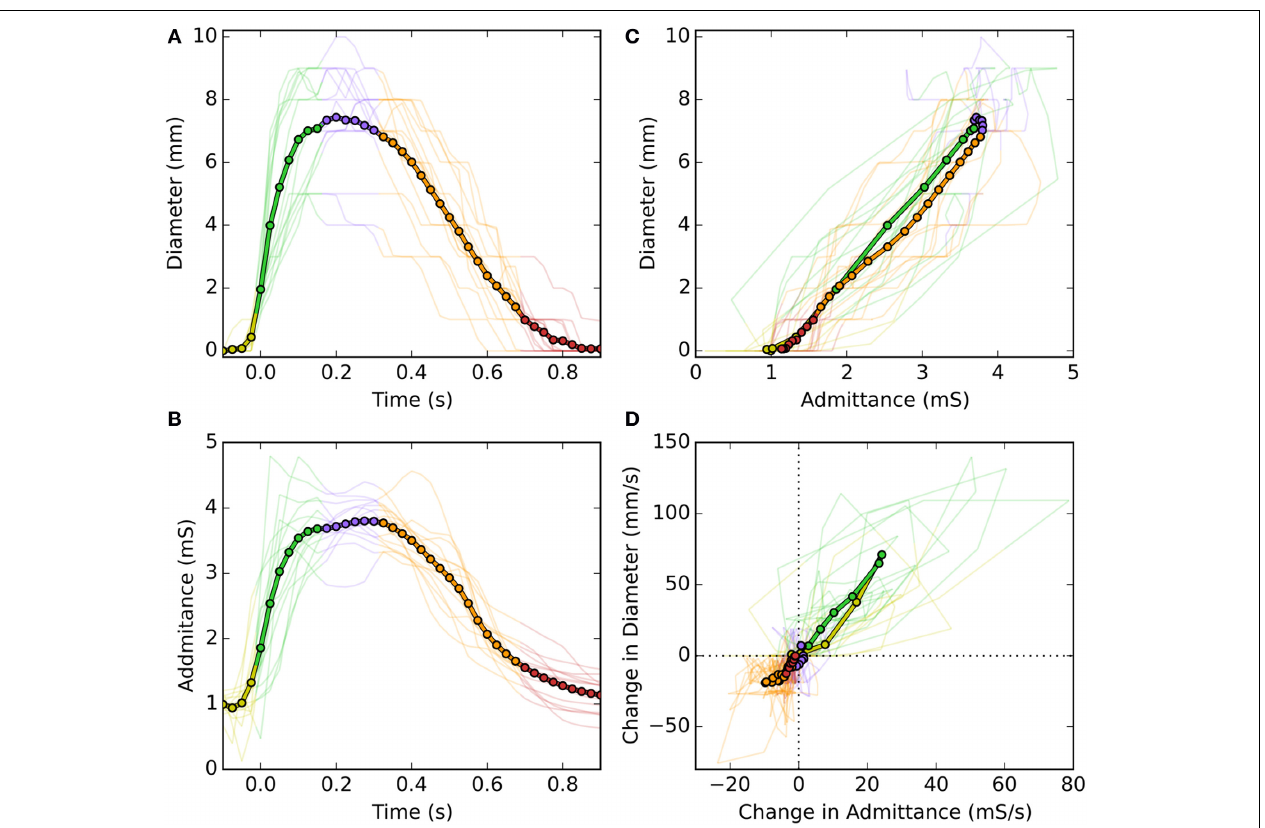
FIGURE 5 | Temporal correlations of UES diameter and UES admittance during a swallow. (A) UES diameter over time of a swallow. (B) UES admittance over the same period of time. (C) Time correlations of diameter vs. admittance. (D) Time correlation of the time derivatives of diameter vs.